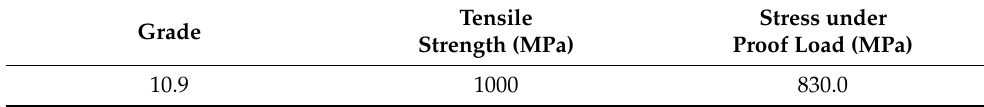
Figure 9. Various element representations of a bolted joint connection. ( a ) FE modeling of tower bottom and TP flange; ( b ) Connection method (Flange: Shell, Bolt: RBE2); ( c ) Connection method (Flange: Shell, Bolt: RBE2+Beam); ( d ) Connection method (Flange: Shell, Bolt: Solid). Table 8. Material properties of bolt.